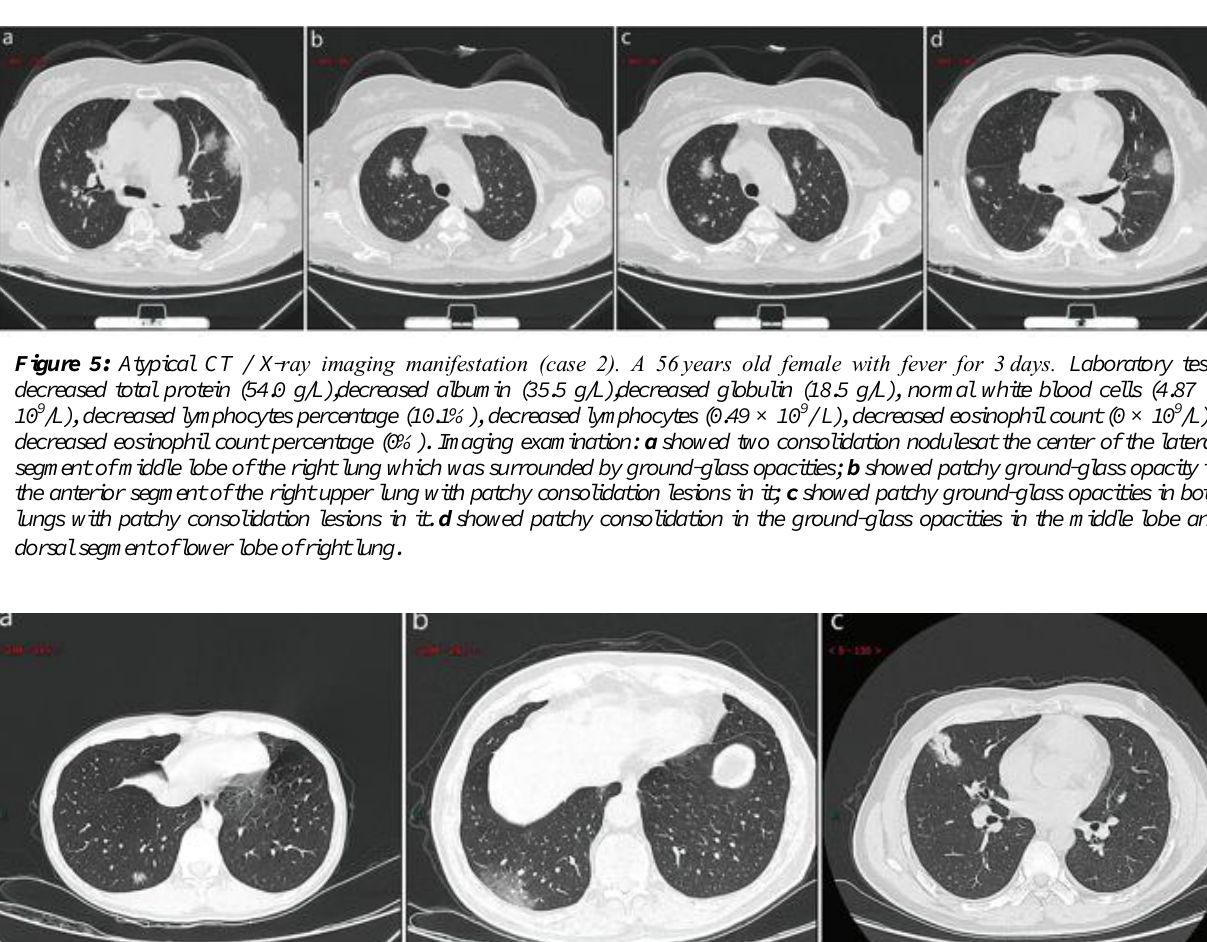
each alveolus through the inter-alveolar space to form a fusion state. The CT manifested a fused and large-scale light consolidation with air- bronchogram inside (Figure 8: 17 cases, 20.5% in a total of 83 cases).  7–14 days after clinical imaging patchy